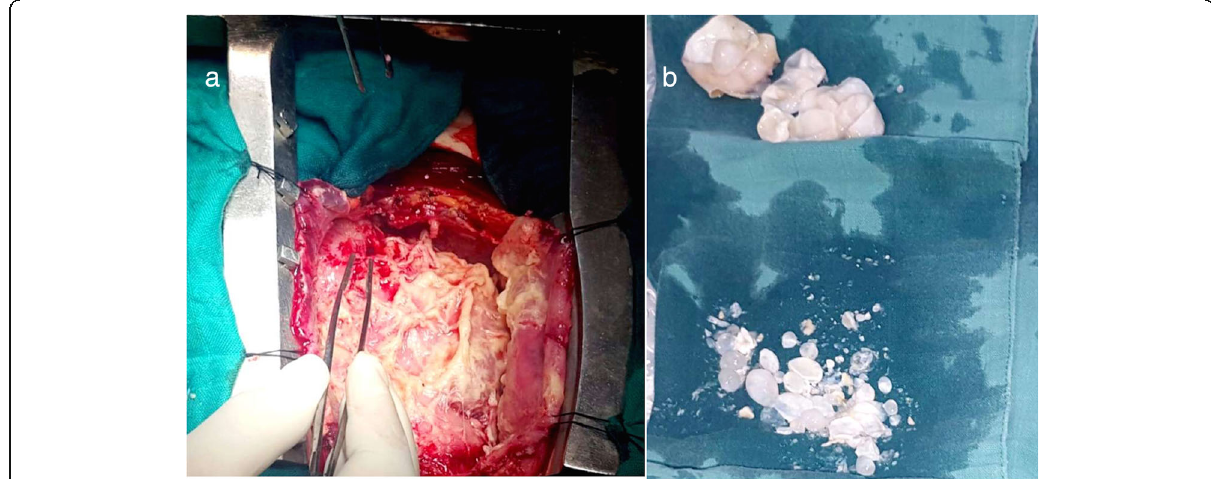
Fig. 2 a Appearance of hydatid cysts of our patient during surgery. b Image of cyst formations after